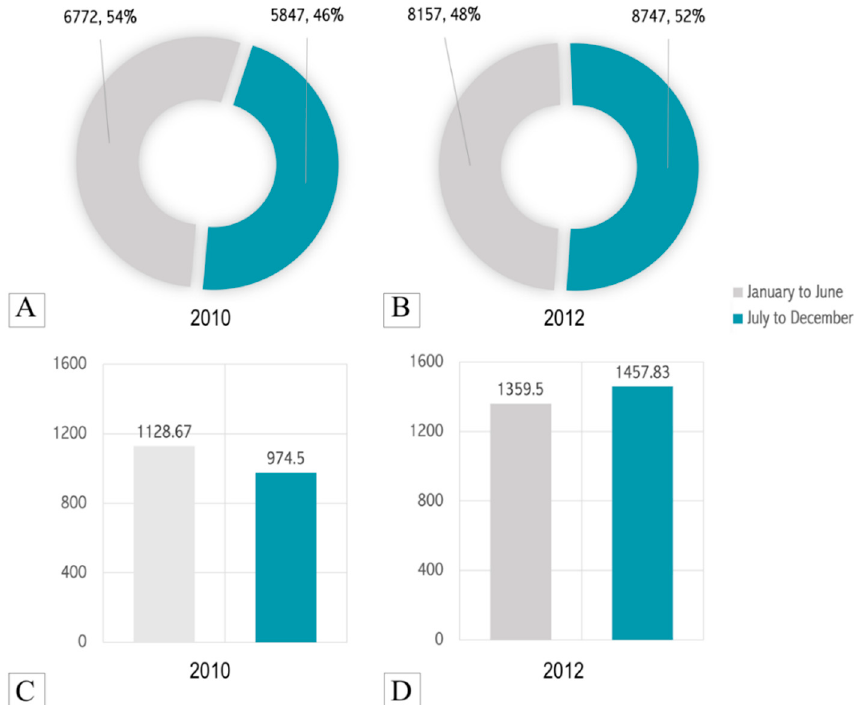
Figure 1. Biannual/seasonal distribution of vaccinated patients (n, %) in 2010 ( A ) and 2012 ( B ). Average number of patients vaccinated per month (n) in each half of 2010 ( C ) and 2012 ( D ).